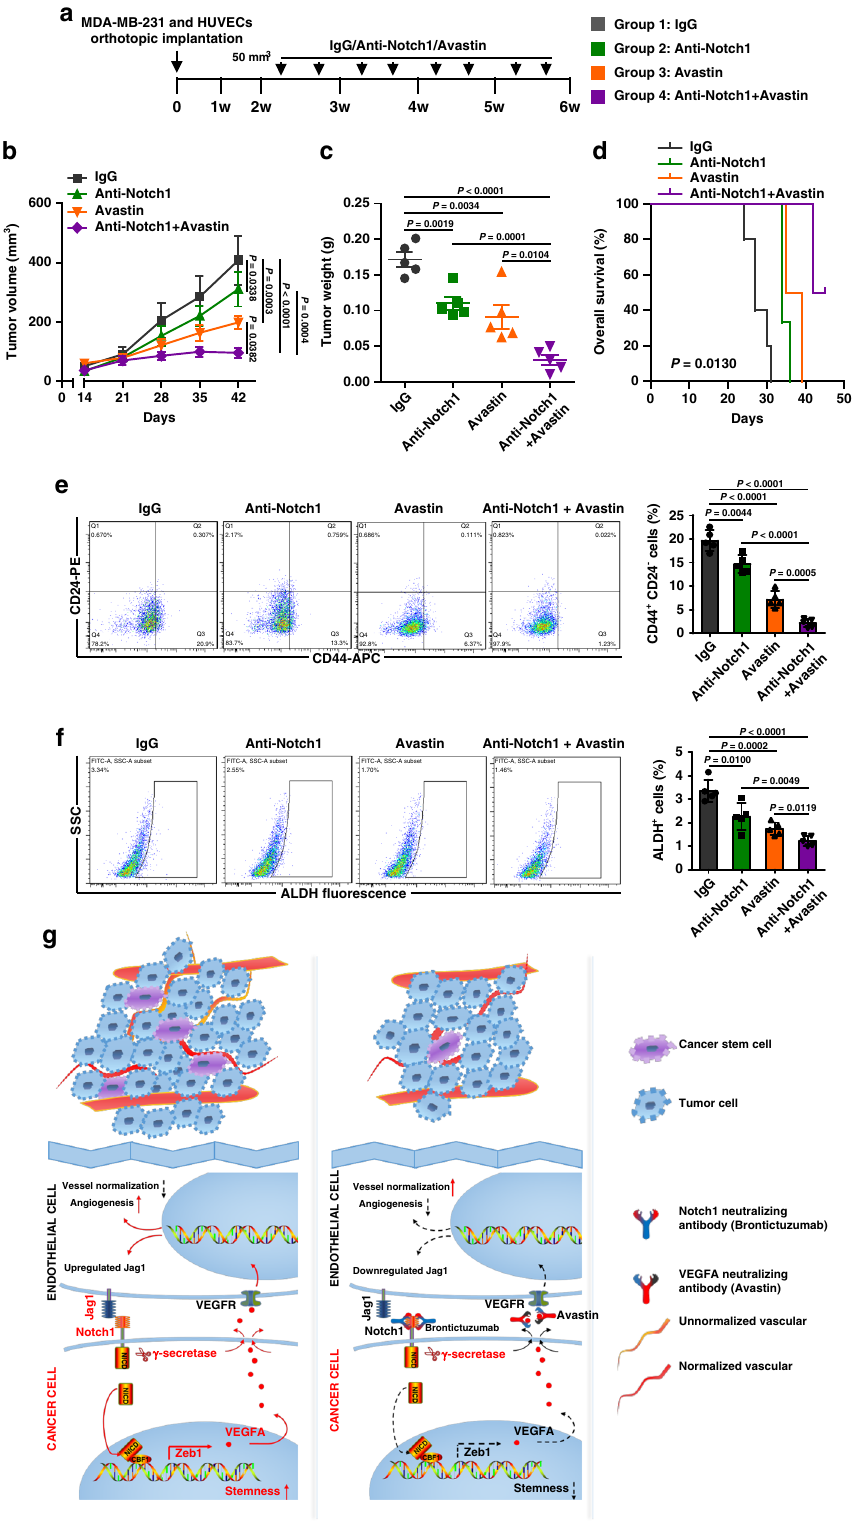
Immunoblotting assay . Cells lysates were prepared in RIPA buffer with protease and phosphatase inhibitors. Protein concentrations was measured using BCA (Thermo) and equal amounts of proteins were loaded on a SDS-polyacrylamide electrophoresis (PAGE) gel. Transfer to polyvinylidene fl uoride membranes (Bio- Rad) for further processing, membranes were next incubated overnight at 4 °C with primary antibodies followed by 1h room temperature incubation with secondary antibodies. The appropriate antibodies were used as described in